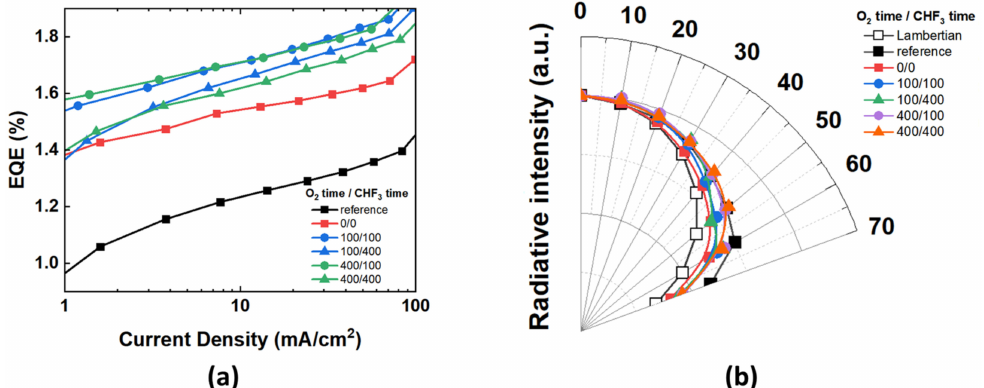
Figure 5. EL characteristics of OLEDs devices without and with nanopatterned/non-patterned MLA ( a ) current density-EQE graph, and ( b ) the angular intensity distribution.